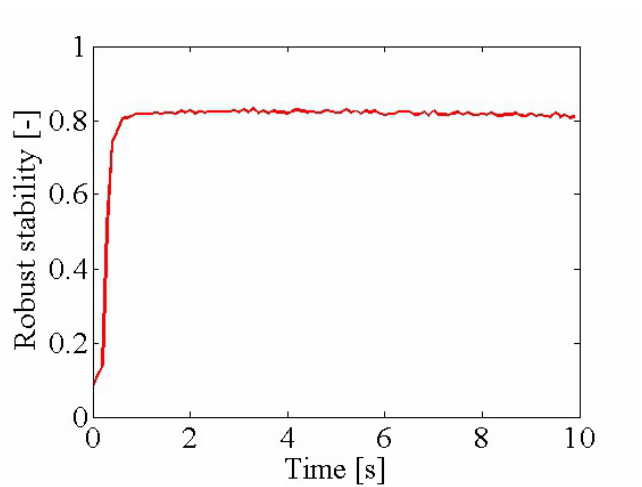
Figure 14. The analysis of robust